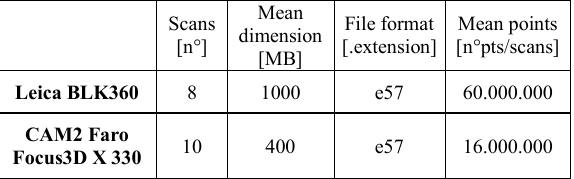
Table 6. Main details of the two TLS